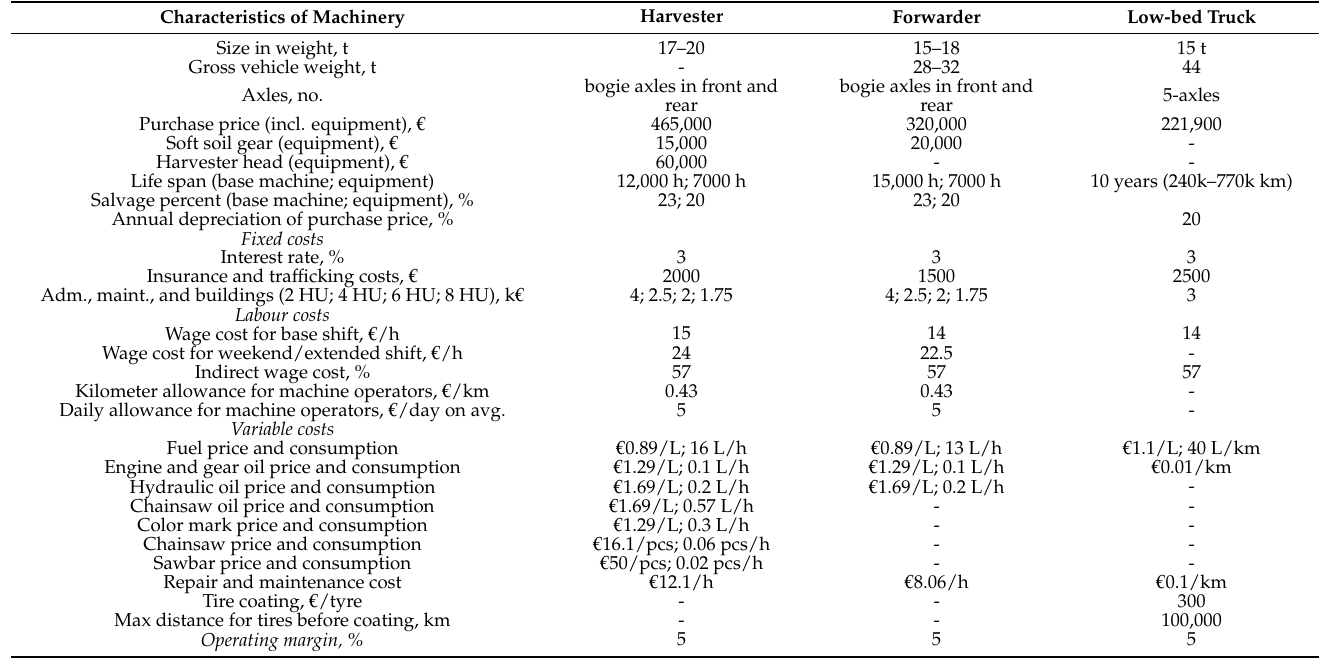
Table 8. Cost accounting factors and the values (excluding VAT) used for calculating costs of the harvesting operations. Characteristics of